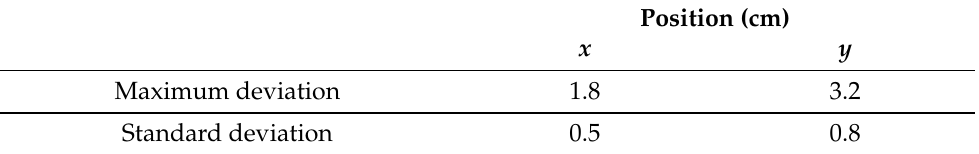
Figure 12. Performance of the STR position teleoperation for the second experiment. First two graphs: user position references in thin red line, actual position values of the STR tool on the workpiece surface (coordinates relative to the surface) in thick blue line, and position limits given by the 2D boundary constraint in dashed lines. Bottom graph: activation of the 2D boundary constraint for the position of the STR tool on the workpiece surface. Table 2. Teleoperation errors for the 2D position p s of the STR tool on the workpiece